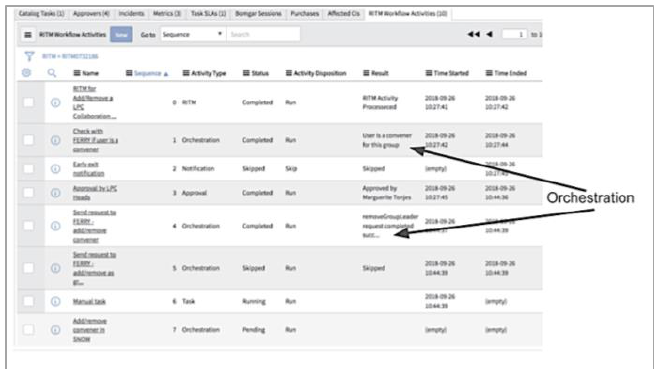
Fig.3. Example of SNOW form workflow with